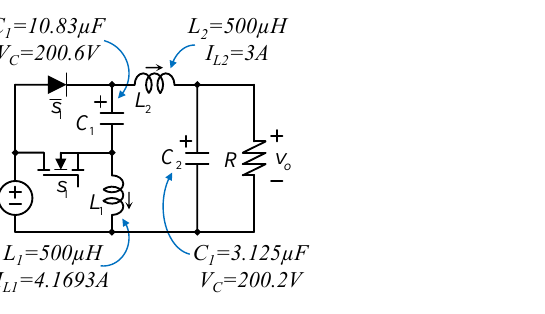
Figure 12. Result of the design with the super-boost converter.